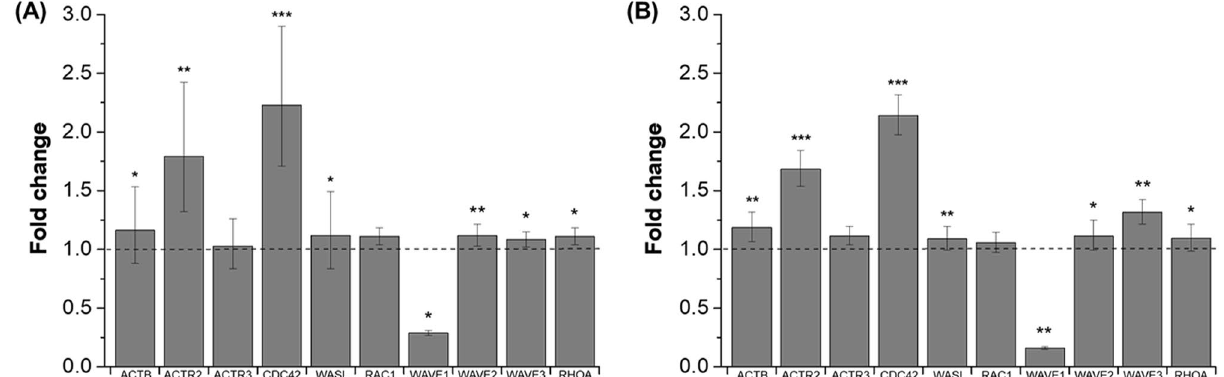
Figure 4. Fold changes in gene expression levels of proteins related to F-actin polymerization in BCa cells. Fold changes in mRNA level following exposure to hypergravity in MCF-7 ( A ), and in MDA-MB-231 ( B ) cells. Housekeeping gene GAPDH and the static control (n = 3) were also analyzed by